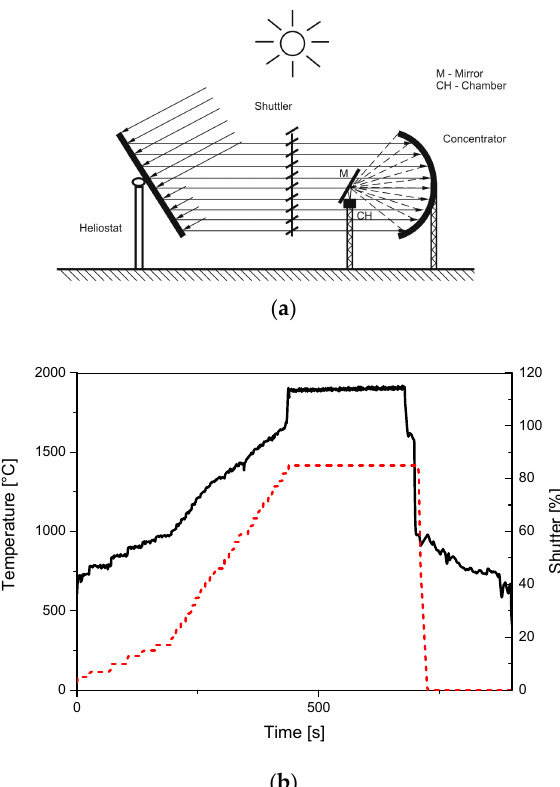
Figure 2. ( a ) Schematic picture of the solar experiment. ( b ) Heating/cooling curve of the solar melting of large titanium sample with 4 min dwell; the shutter opening (dash curve) is plotted on the secondary y axis. Heating rate 150 K/min; solar direct radiation 675 ± 20 W/m 2 .